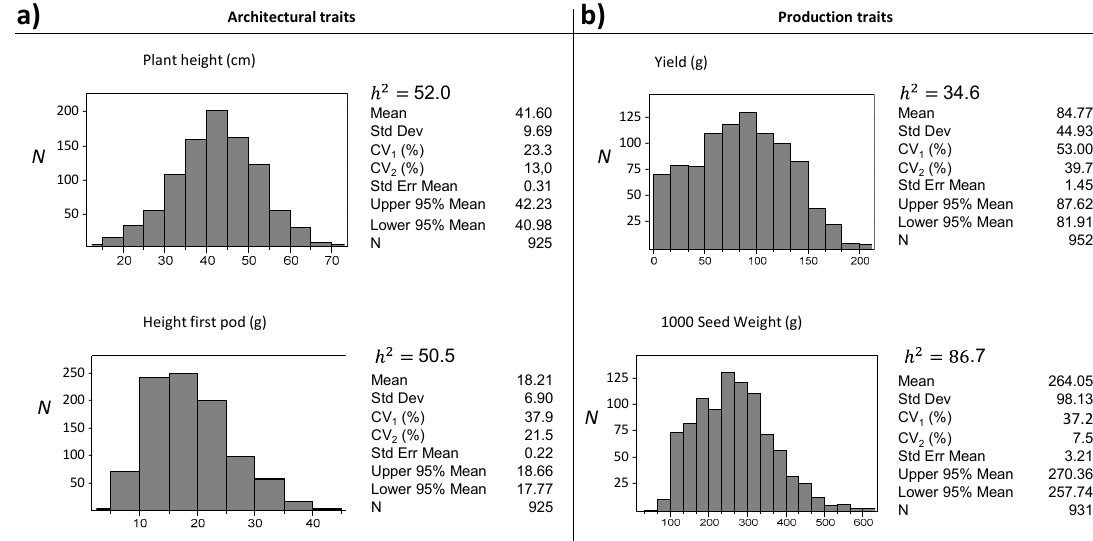
Figure 4. Frequency distribution and heritability estimates of the architectural ( a ) and production ( b ) traits across the UNIVPM_Ca_core2 panel; N , number of accessions; CV 1 , coefficient of variation based on the population mean; CV 2 , coefficient of variation between biological replicates.